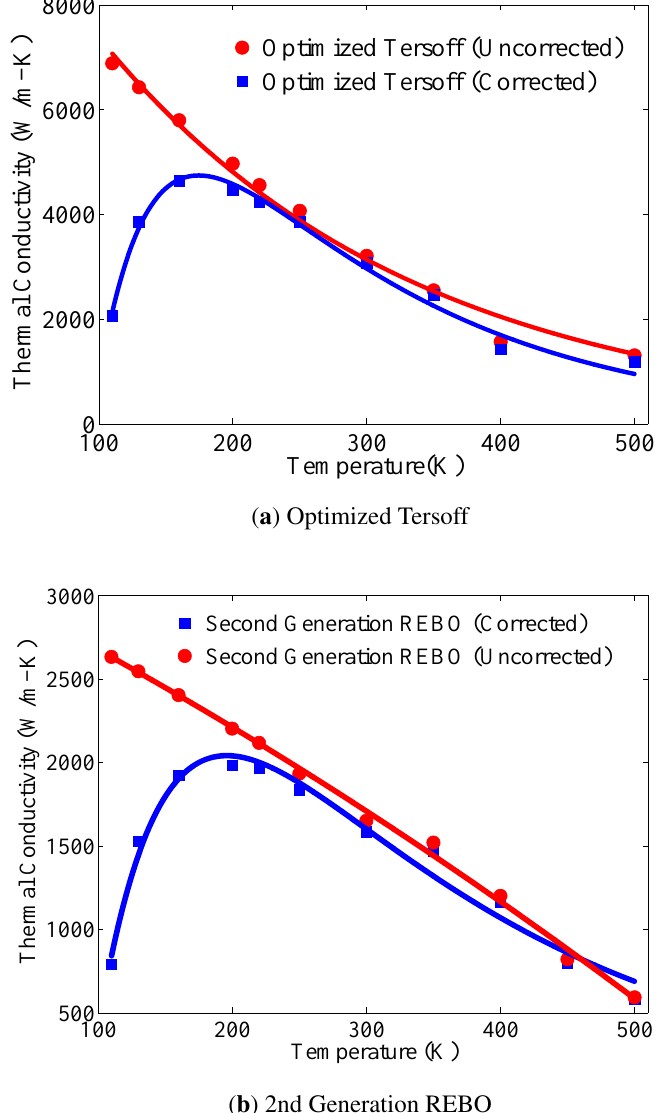
Figure 5. Quantum corrected and uncorrected thermal conductivity of GNR (10nm × 1nm) as a function of temperature using ( a ) optimized Tersoff and ( b ) 2nd generation Reactive Empirical Bond Order (REBO)